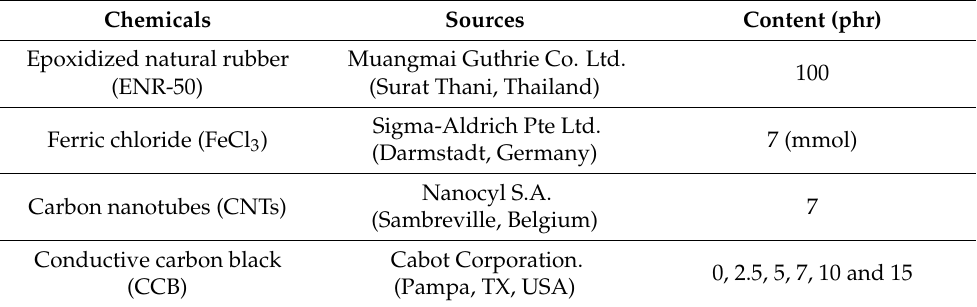
Table 1. Chemical ingredients with sources and compounding formulation of ENR-50 with FeCl 3 and CNT–CCB hybrid